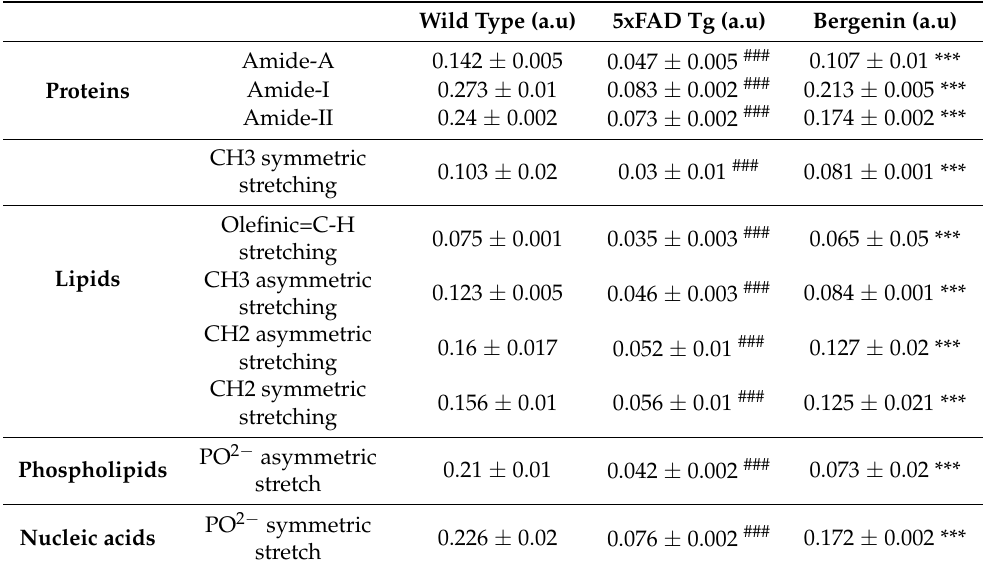
Table 1. Peak intensities (a.u) of proteins, lipids, phospholipids and nucleic acids of wild-type, 5xFAD Tg and Bergenin-treated groups. Wild Type (a.u) 5xFAD Tg (a.u) Bergenin